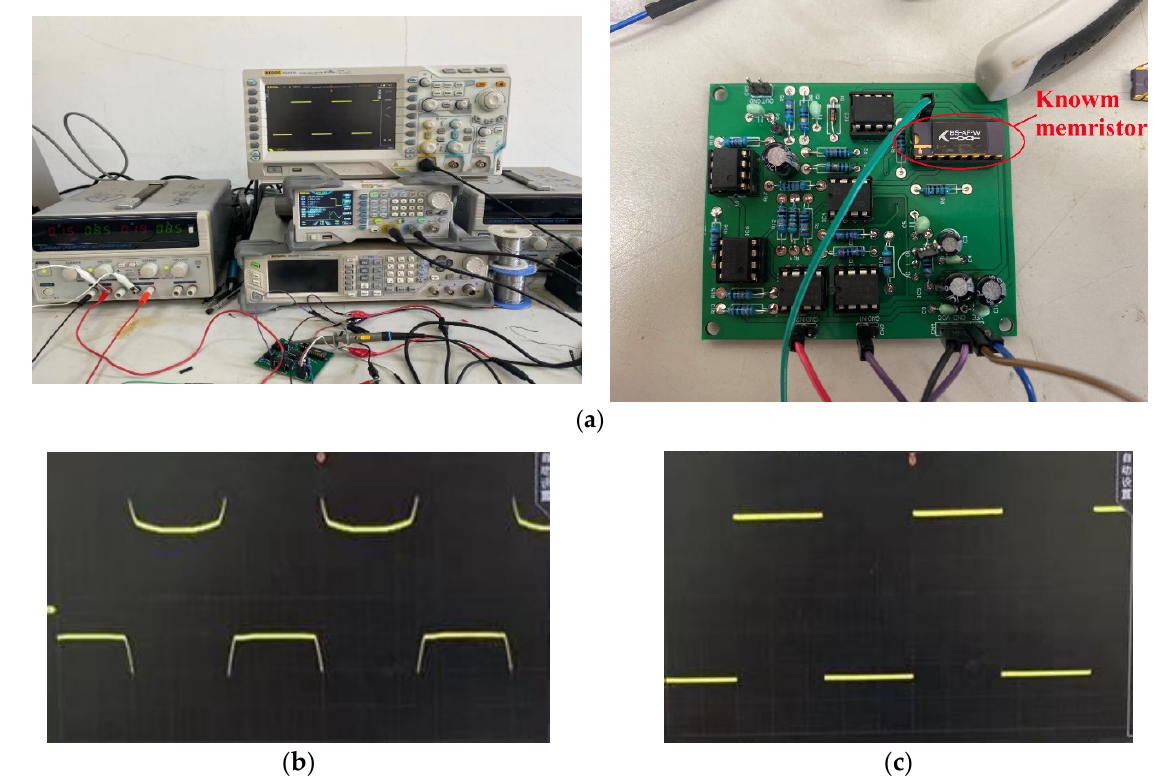
Figure 9. Hardware experiment setup and waveform. ( a ) Experimental setup ( b ) Modulated wave- form ( c ) Demodulated waveform.